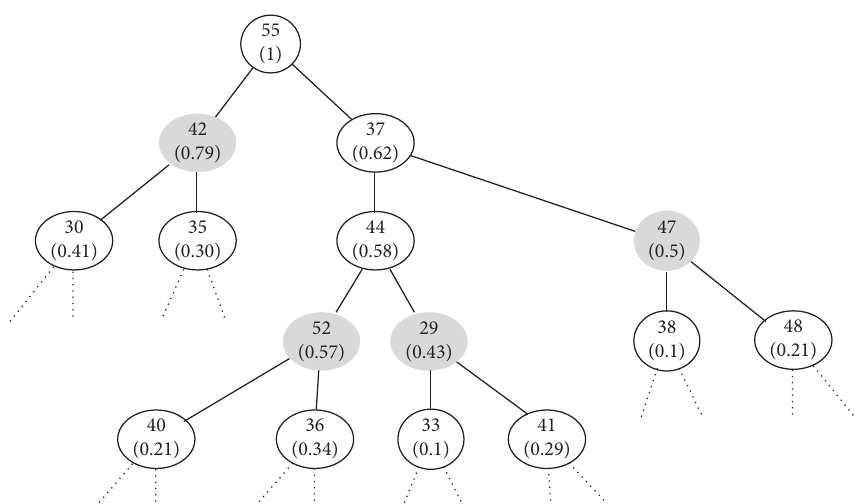
Figure 7: An example of applying branch and bound technique on a modularization tree (see Algorithm 2).3.3. Genetic Operations.